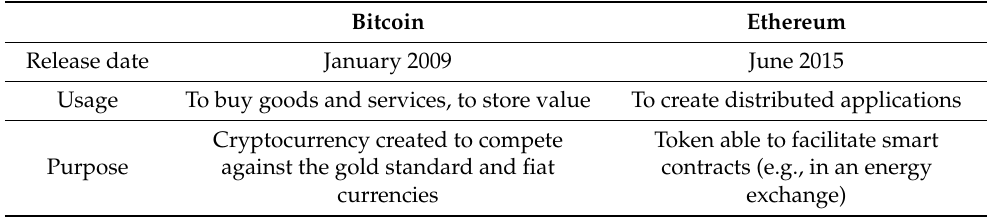
Table 3. Comparison between Bitcoin and